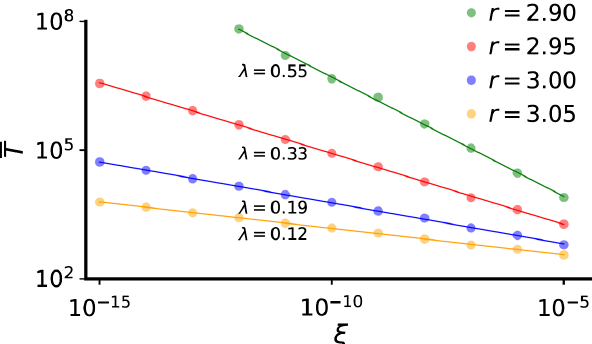
¯ T FIG. 2. Average switching period as a function of the noise intensity ξ for σ ¼ 1 . 7 and various values of r [dots in Fig. 1(b)]. The switching periods are extracted from long time series of switching chimeras obtained by simulating Eq. (1) for different values of ξ . The numbers indicate the scaling exponents and are obtained through least-square fit (slopes of the solid